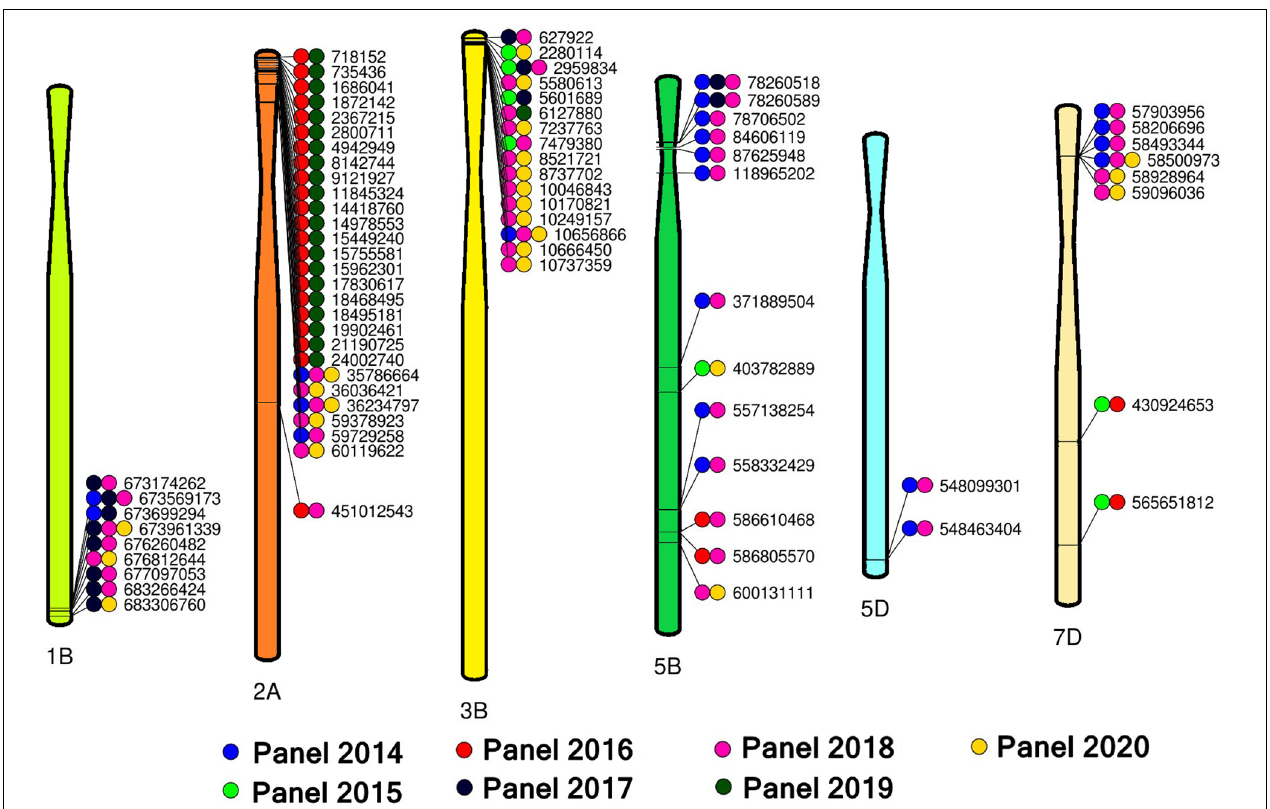
FIGURE 4 | A reference map with 76 spot blotch associated markers significant in two or more panels on chromosomes 1B, 2A, 3B, 5B, 5D, and 7D.